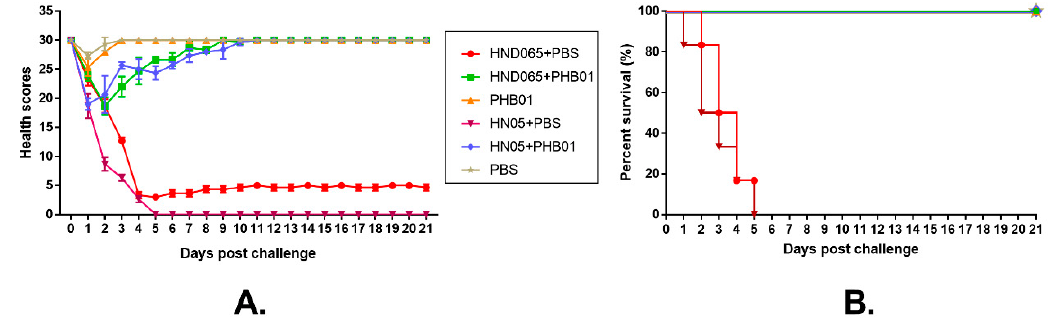
Figure 8. Protective effects of the phage PHB01 in mice challenged with wild-type P. multocida strain HND065 and HN05. ( A ) Health scores given to the mice in different groups. The total score for the health status of each group was recorded at least three times per day. The data are expressed as the mean ± SD; ( B ) Survival curve of the mice in each of the groups during the experiment.